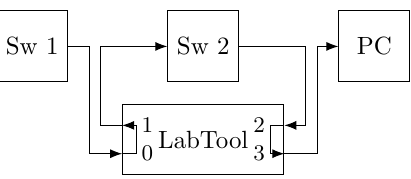
Figure 17. Topology used to measure the jitter in the absence of